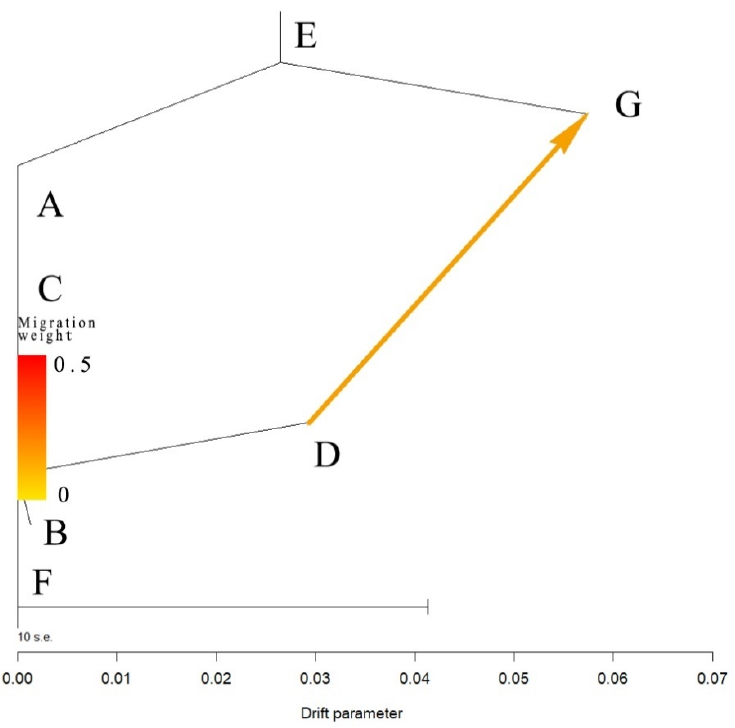
Figure 7. Detection of gene flows among A. exitialis populations by TreeMix analysis.